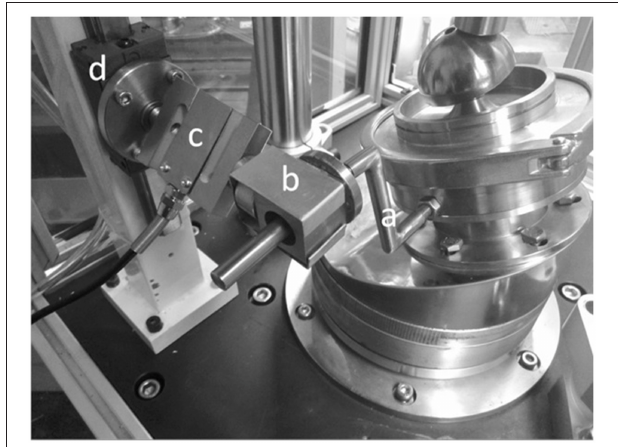
FIGURE 2 | Friction measurement module for HSMS 4203 : (a) Z-shaped leaning lever, (b) bearing housing, (c) senor, (d) linear bearing and